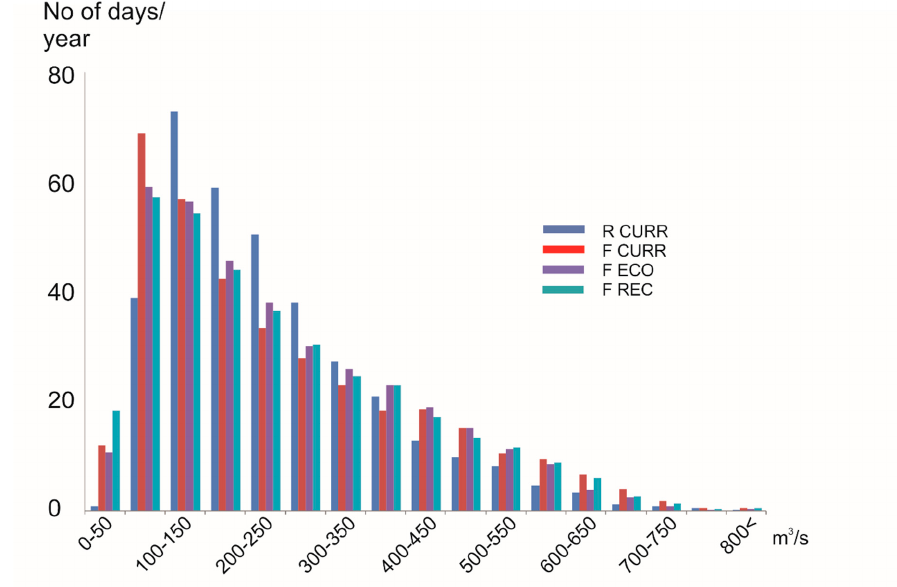
Figure 9. The distribution of daily discharges (in number of days / year) at the city of Pori. Data were modeled in the study by Dubrovin et al. [51].